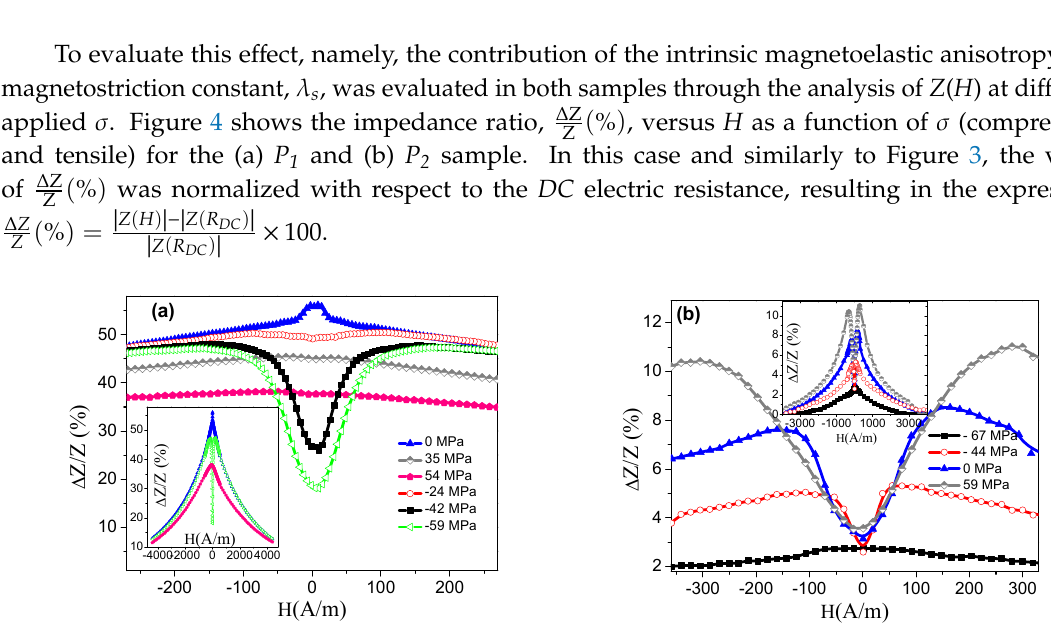
Figure 4 . Evolution of the relative variations of impedance, P 2 . Samples were excited with a current amplitude of I pp = 40 and ( b ) P 2 . Samples were excited with a current amplitude of I pp = 40 mA.